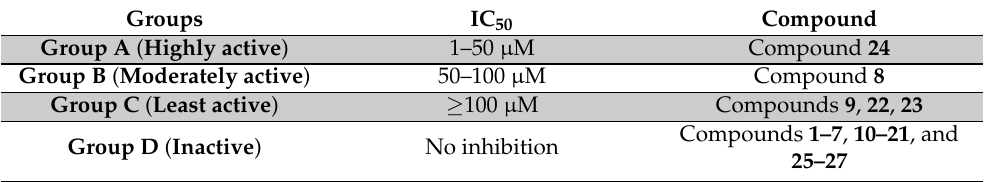
Table 2. Classification of all synthesized compounds 1–27